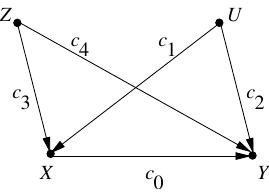
Figure 2: Model in which Z is both a confounder and an (imperfect) instrumental variable relative to X, Y